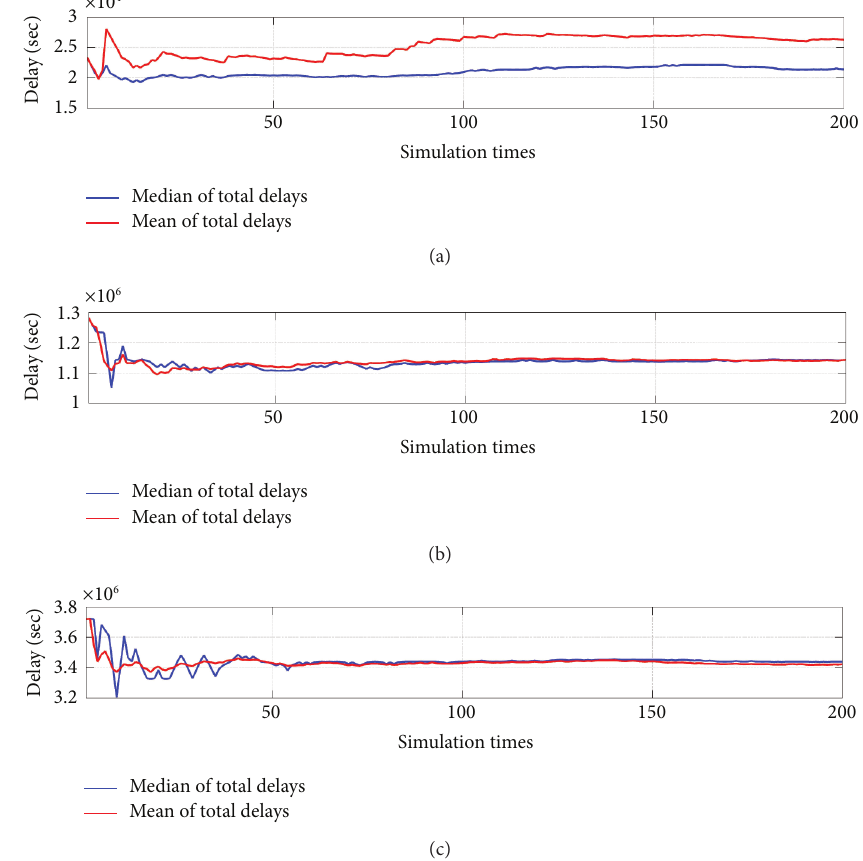
Figure 13: Median and mean of the total delays with different simulation times (a) when 1000 cars arrive, (b) when 2000 cars arrive, and (c) when 3000 cars arrive.